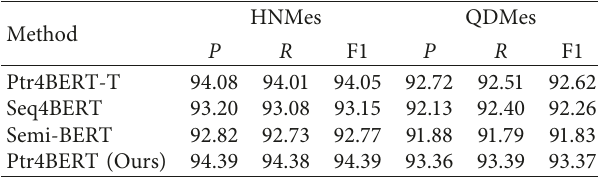
Figure 4: Confusion matrix after classification of HNMes and QDMes, where URC stands for urban and rural construction, EP stands for environmental protection, TRANS stands for transportation, EDU stands for education, TRADE stands for trade, MC stands for medical care, and SS stands for social security. Table 3: Performance of ablation experiments.